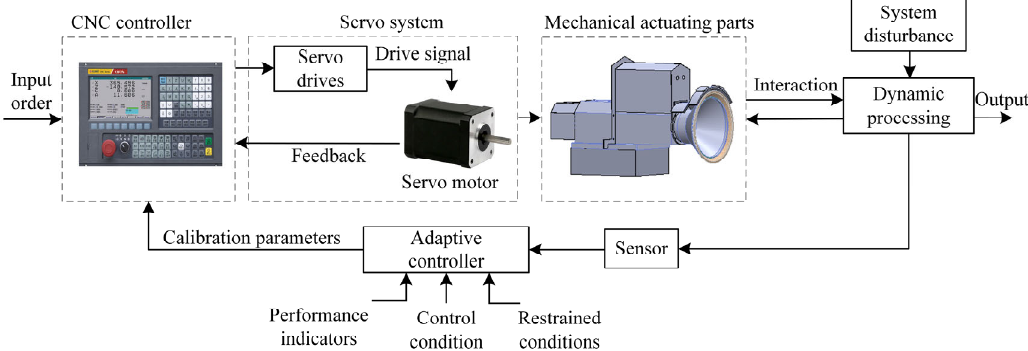
Figure 2. Machine tool adaptive control system.